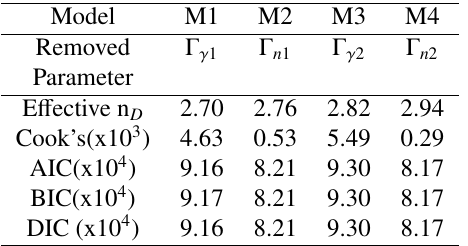
Table 2. Cook’s distance, information criteria and e ff ective degrees of freedom for di ff erent model